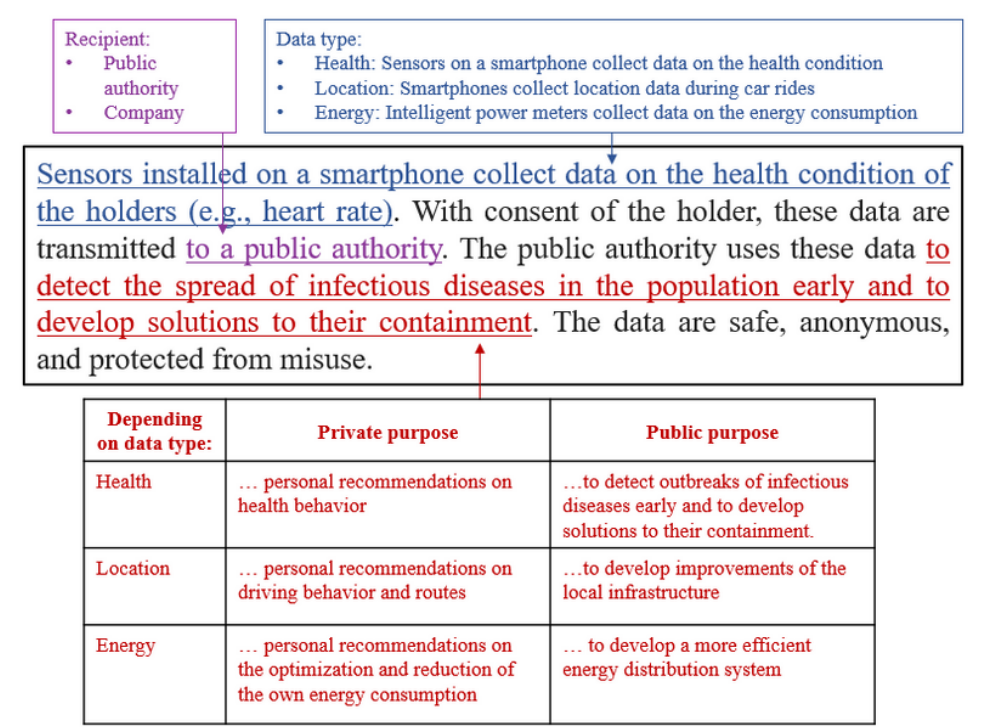
Figure 1. Example vignette as well as dimensions and levels of the other vignettes. The vignettes varied along the indicated data type, recipient, and data